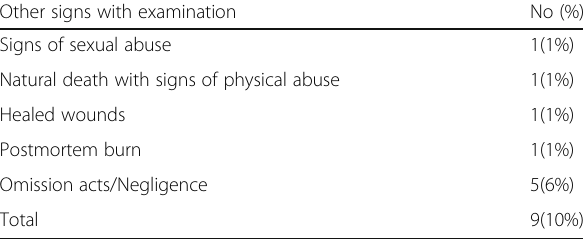
Table 5 Child cases showing other signs on